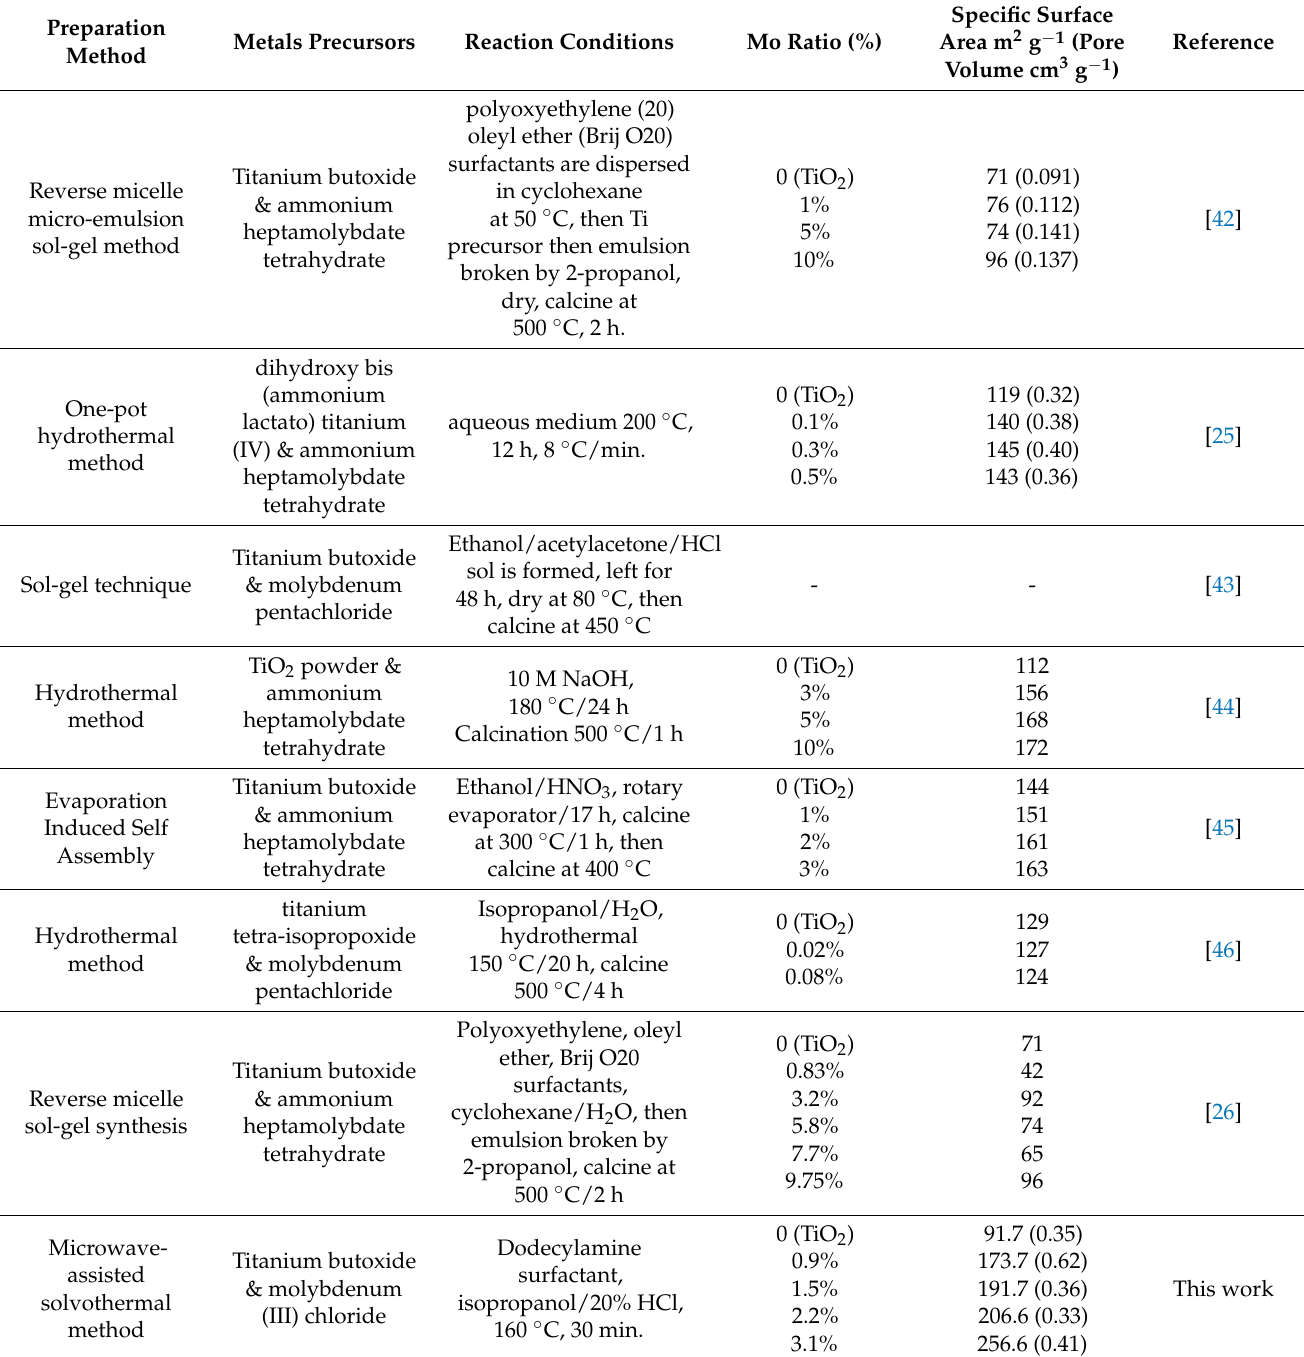
Table 2. Summary of some previous studies demonstrating the synthesis of Mo-doped TiO 2